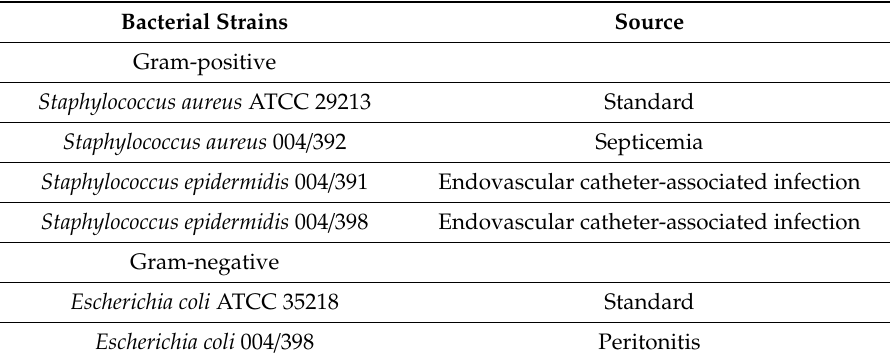
Table 1. Gram positive and negative strains used to test PES / ZnO membranes. Strain numbers refer to an internal directory for